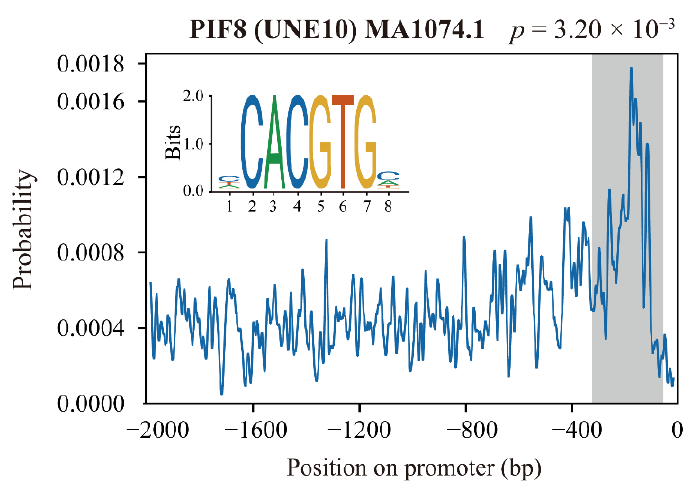
Figure 7. The distribution preference of the PIF8 binding site in the promoter region of genes in the “Blue” and “Turquoise” modules.